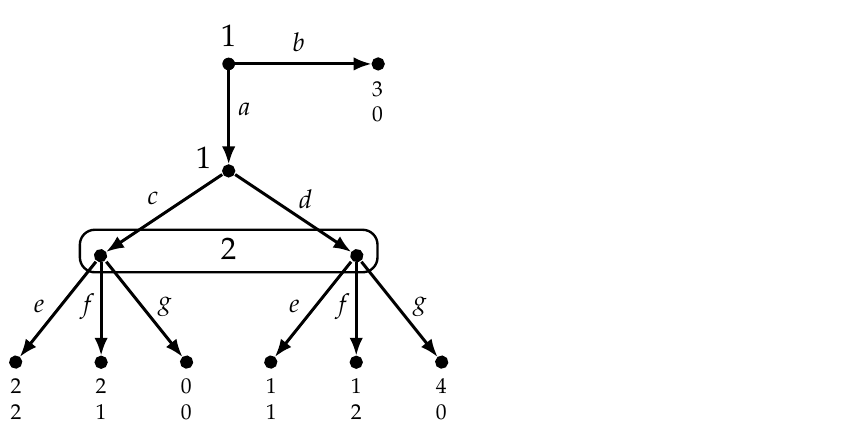
Figure 2. The conflict between the backward-induction-based counterfactual and the forward- induction-based counterfactual encoded in Player 2’s